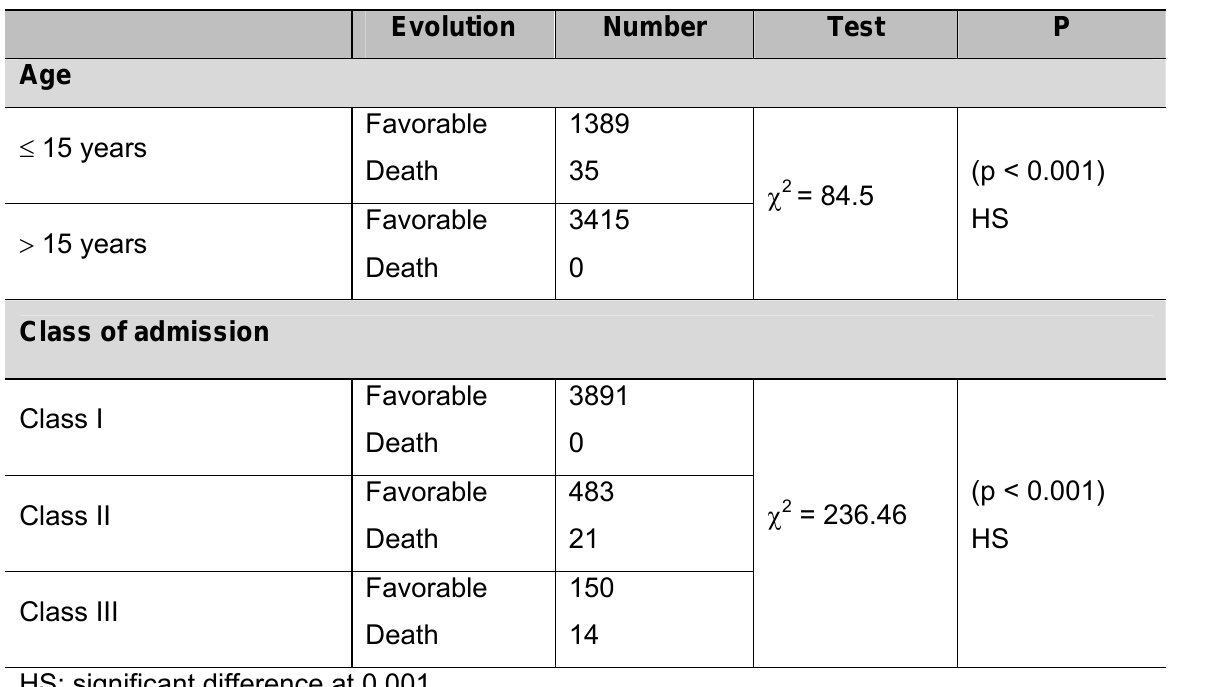
Table 2. Characteristics of two groups of evolution